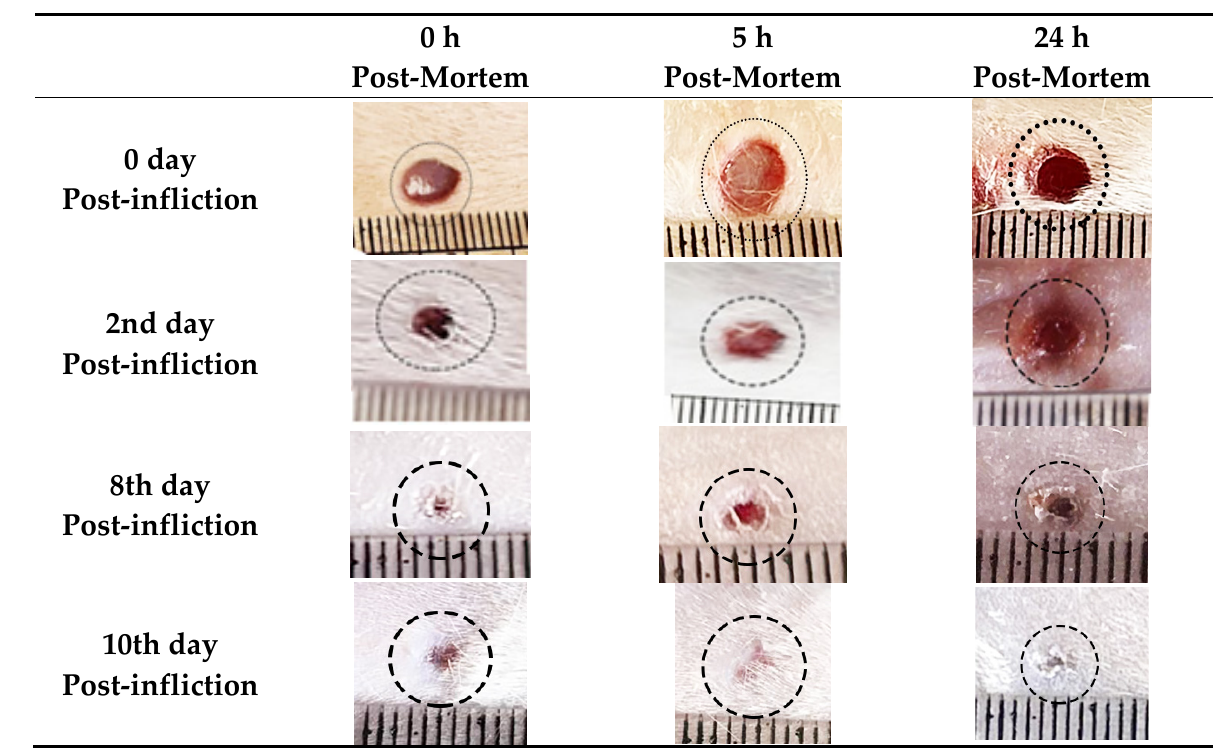
Figure 1. Photograph showing wound healing progression on day 0, day 2, day 4, day 8, and day 10 post-wounding at different postmortem intervals (0, 5th, and 24th h); each grade in the scale equal 1 mm.